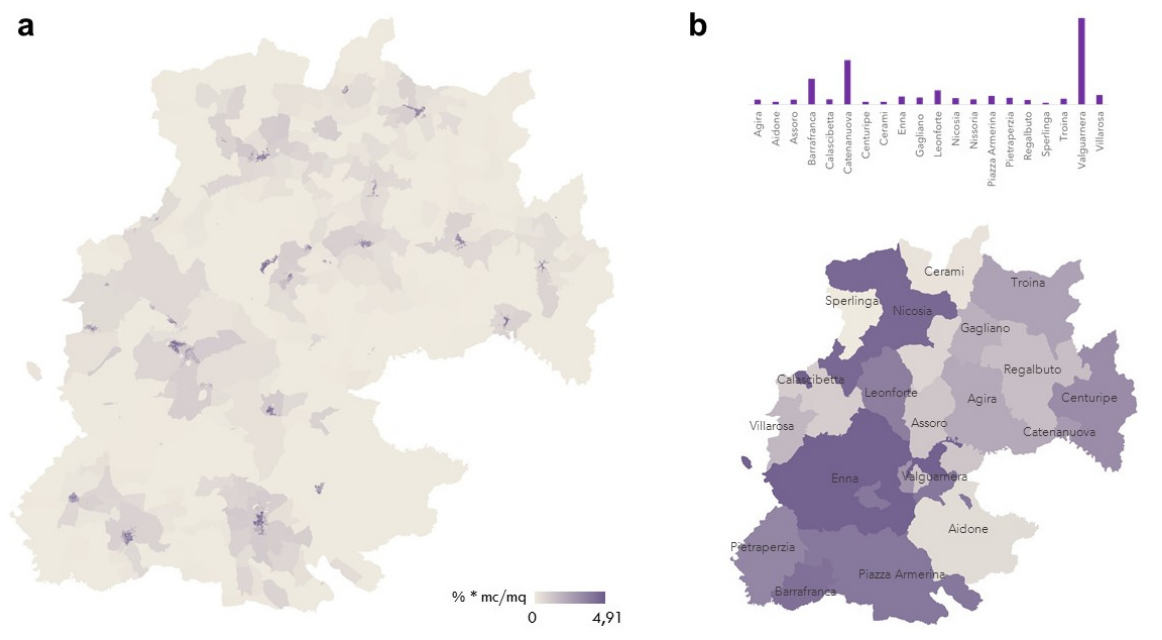
Figure 13. Building utilization rate on the double scale of the Census Sections ( a ) and Municipalities ( b ) (numerical values under the colour ramp).